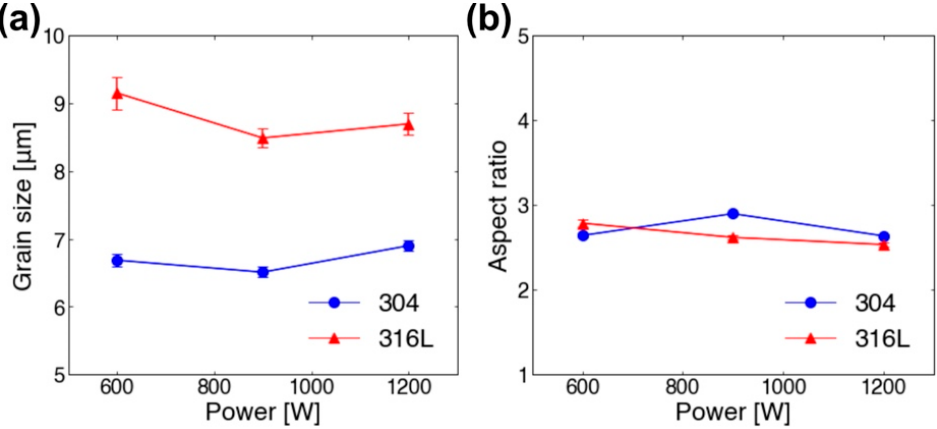
Figure 5. ( a ) Average grain size and ( b ) their aspect ratio evaluated from EBSD IPF orientation maps taken from the electron-beam irradiated regions in 316L and 304 SS samples.